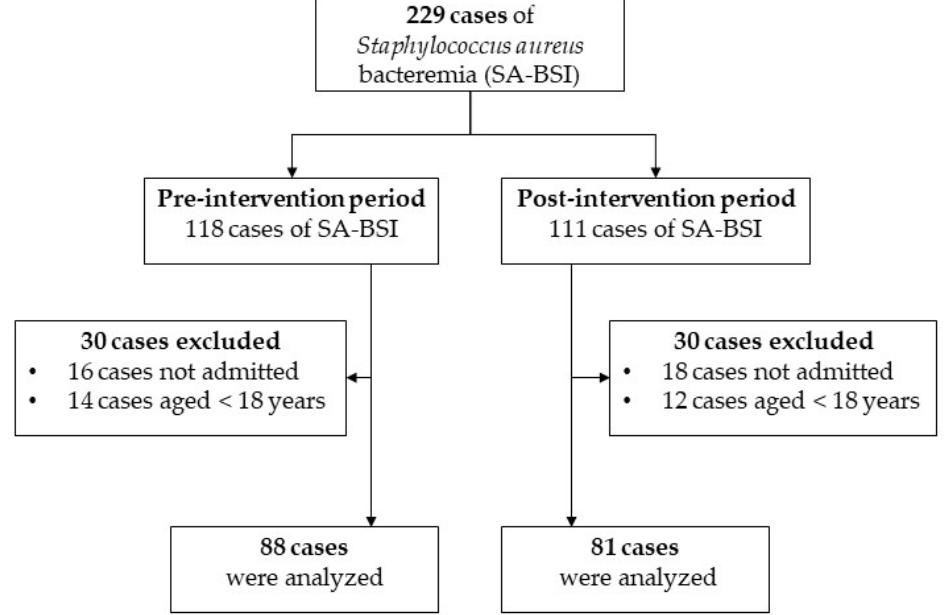
Figure 1. Flow diagram of the cases of Staphylococcus aureus bloodstream infection included in the study.